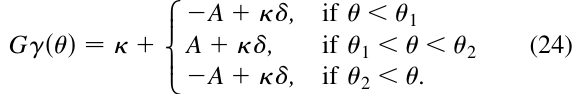
(cid:1) 9 (cid:7) . The two 1 2 2